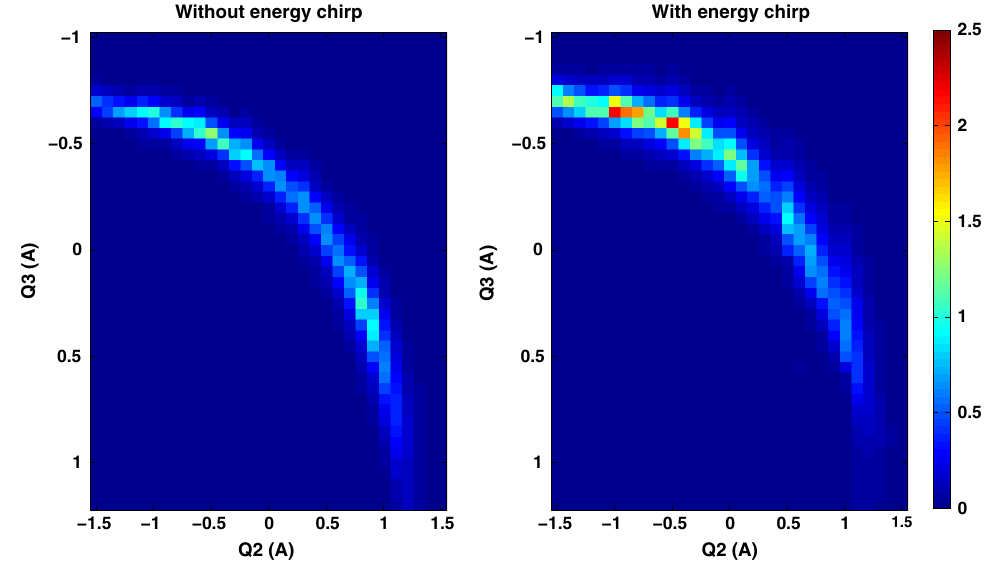
FIG. 13. Pyrodetector measurements of coherent transition radiation at X24 as a function of upstream quadrupoles Q2 and Q3. No energy chirp on the beam (left) and with an energy chirp on the beam (right) at 40 degrees off crest. The intensity obtained when the beam is chirped is a factor of 2 higher compared with the no chirp case at certain quadrupole